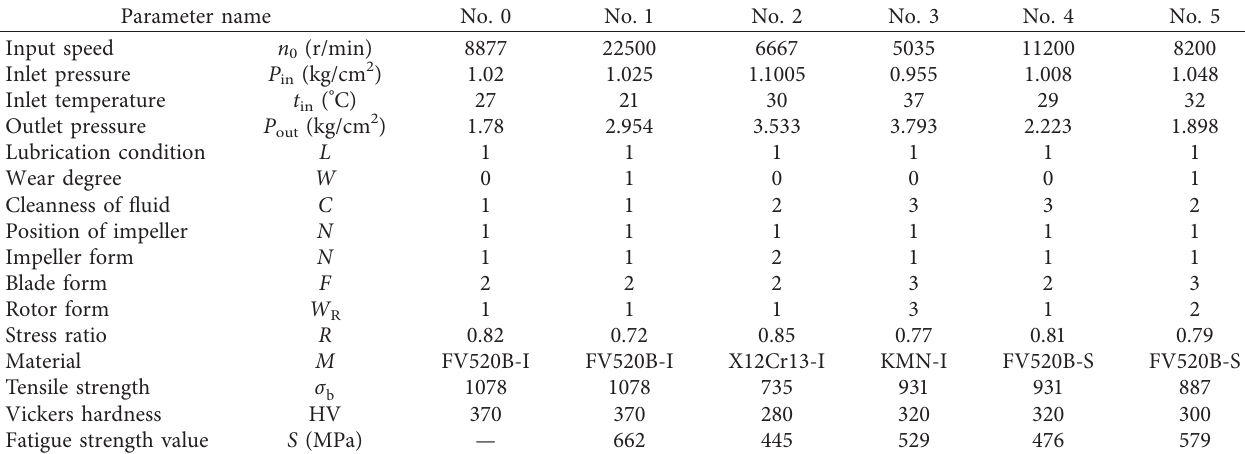
Table 3: Parameter of working condition, transmission mode, and material property of the reference